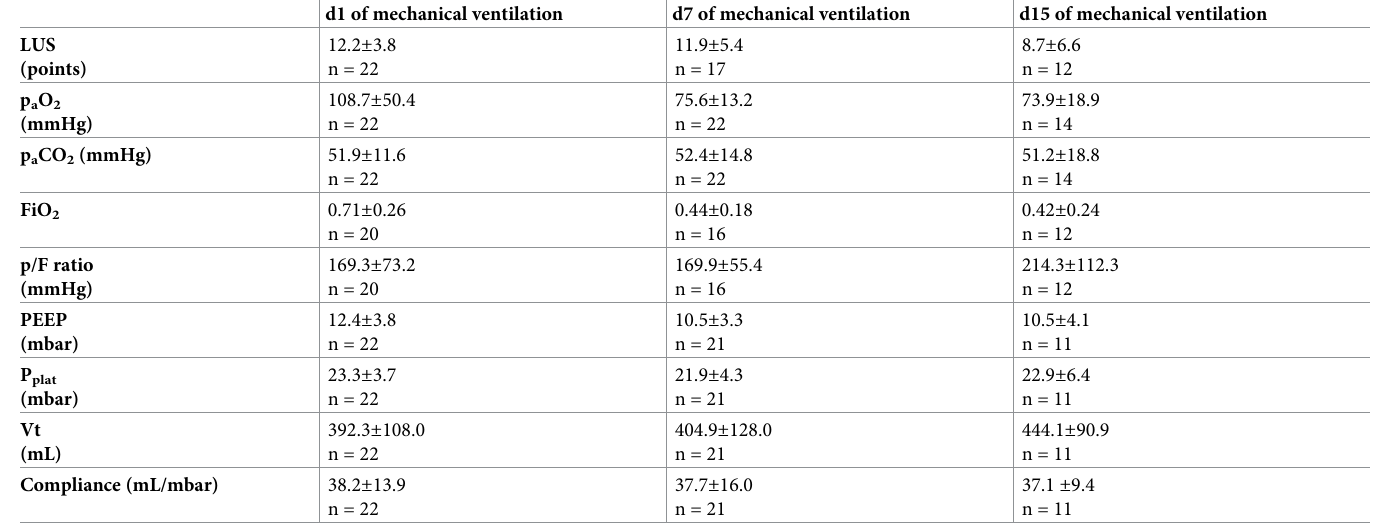
Table 6. Course of respiration and mechanical